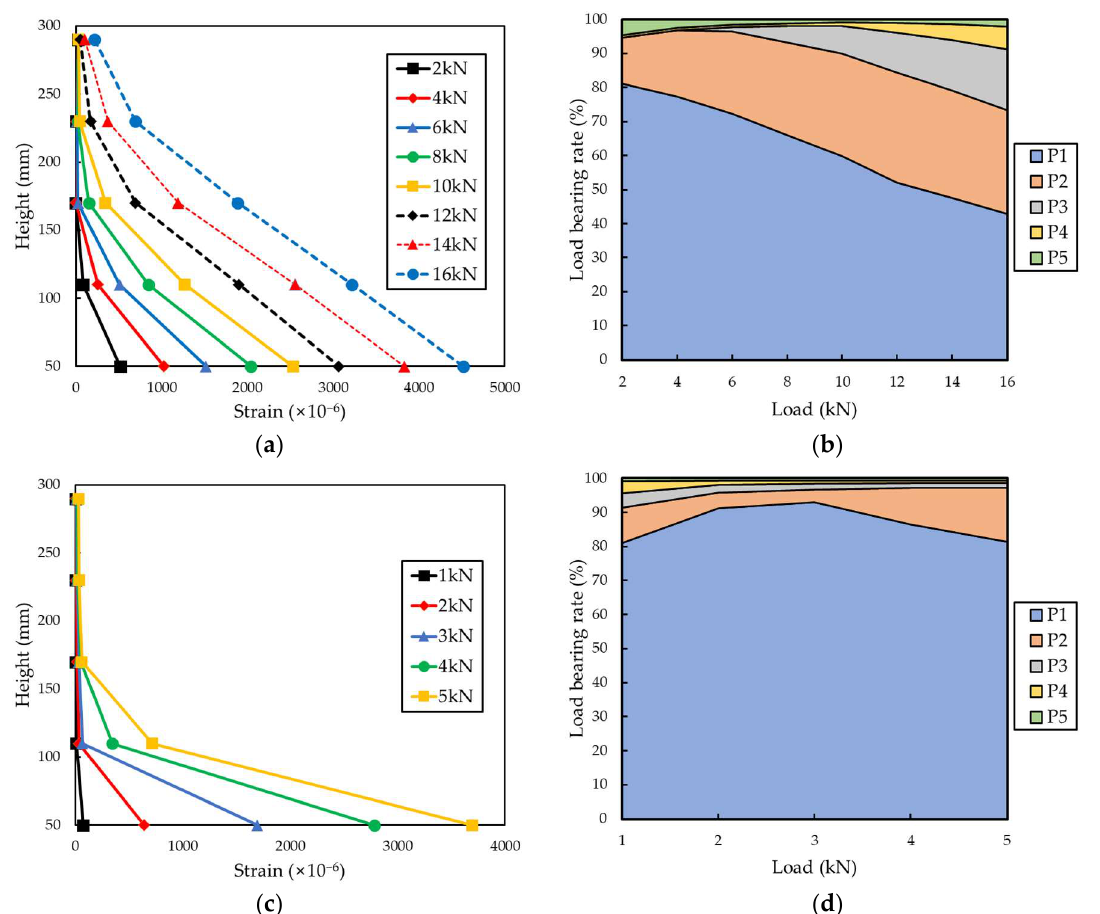
Figure 11. Tensile strain distribution and load-bearing rate of each point of P.C-1 and P.G-1. ( a ) Tensile strain distribution of P.C-1. ( b ) Load-bearing rate of each point of P.C-1. ( c ) Tensile strain distribution of P.G-1. ( d ) Load-bearing rate of each point of P.G-1.